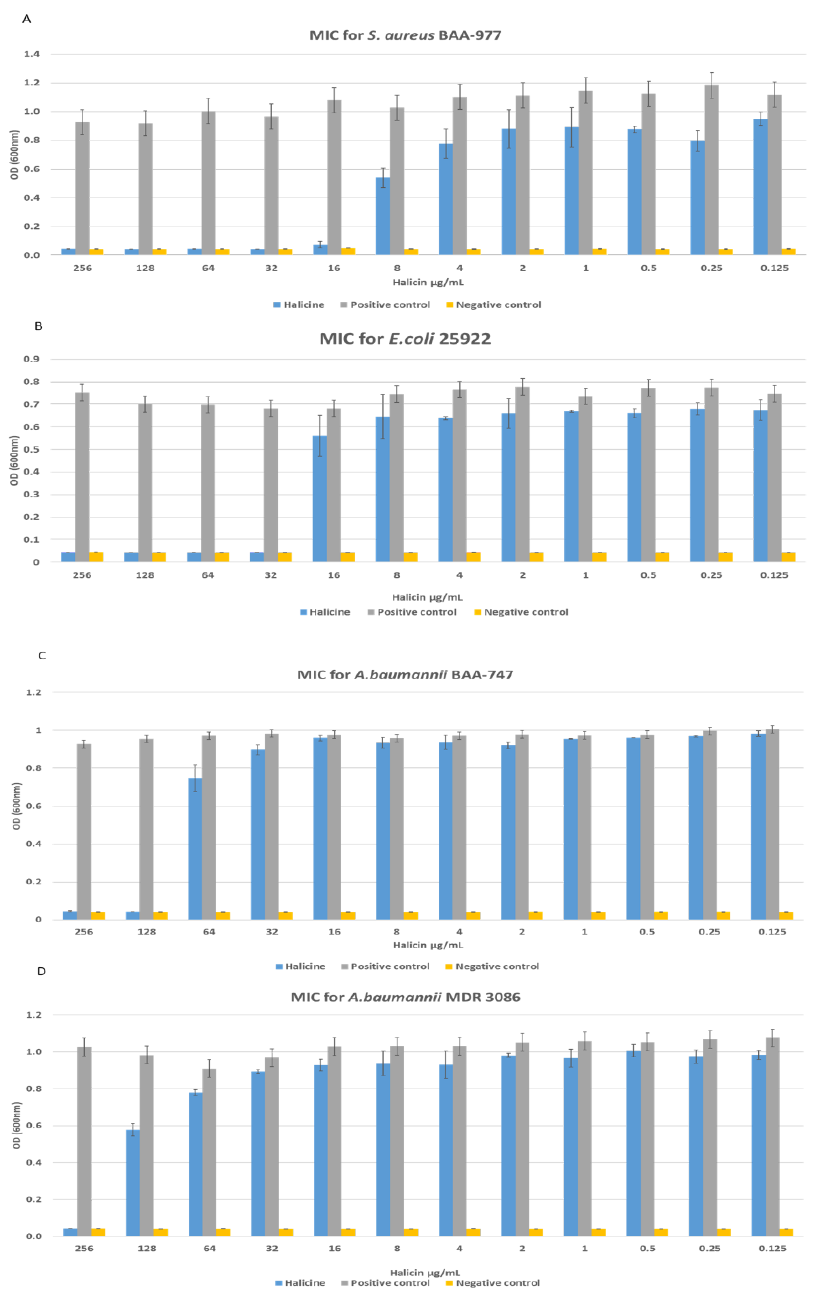
Figure 8. The minimum inhibitory concentration (MIC) values of halicin against S. aureus (BAA 977), E. coli (ATCC 22925), A. baumannii (BAA 747), and A. baumannii (MDR 3086), in which the minimum concentration (orange circled) is defined as the lowest concentration of no bacterium growth. The MIC was found at 16 μg/mL, 32 μg/mL, 128 μg/mL, and 256 μg/mL against S. aureus , E. coli , A. baumannii , and MDR A. baumannii , respectively.